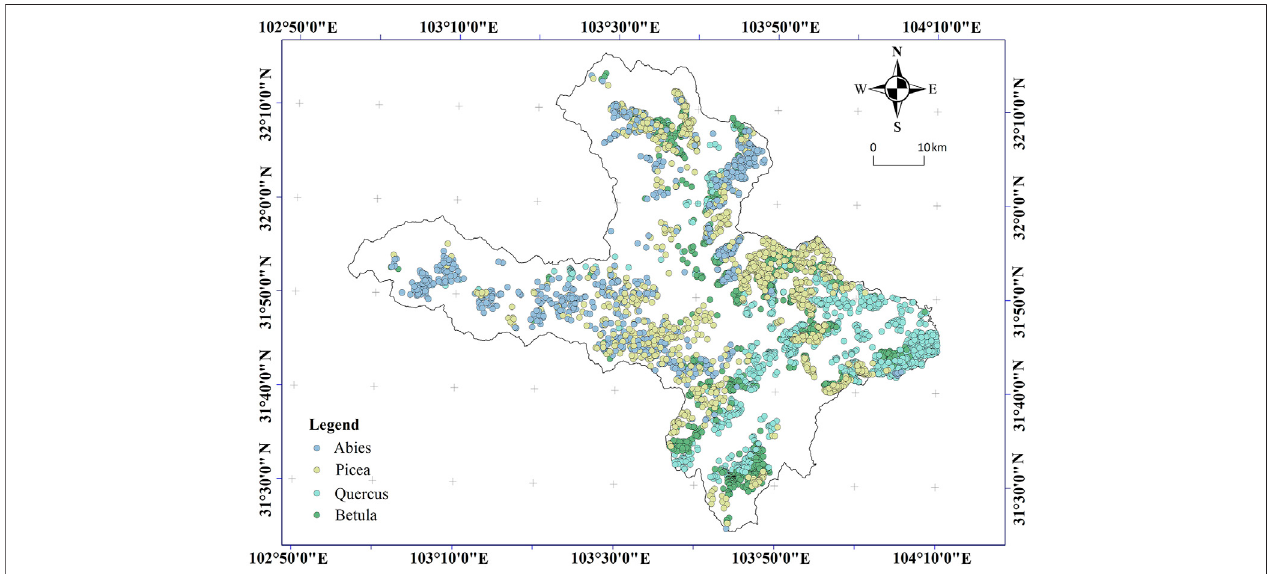
FIGURE 2 | Locations of sampling points of the four dominant tree species.